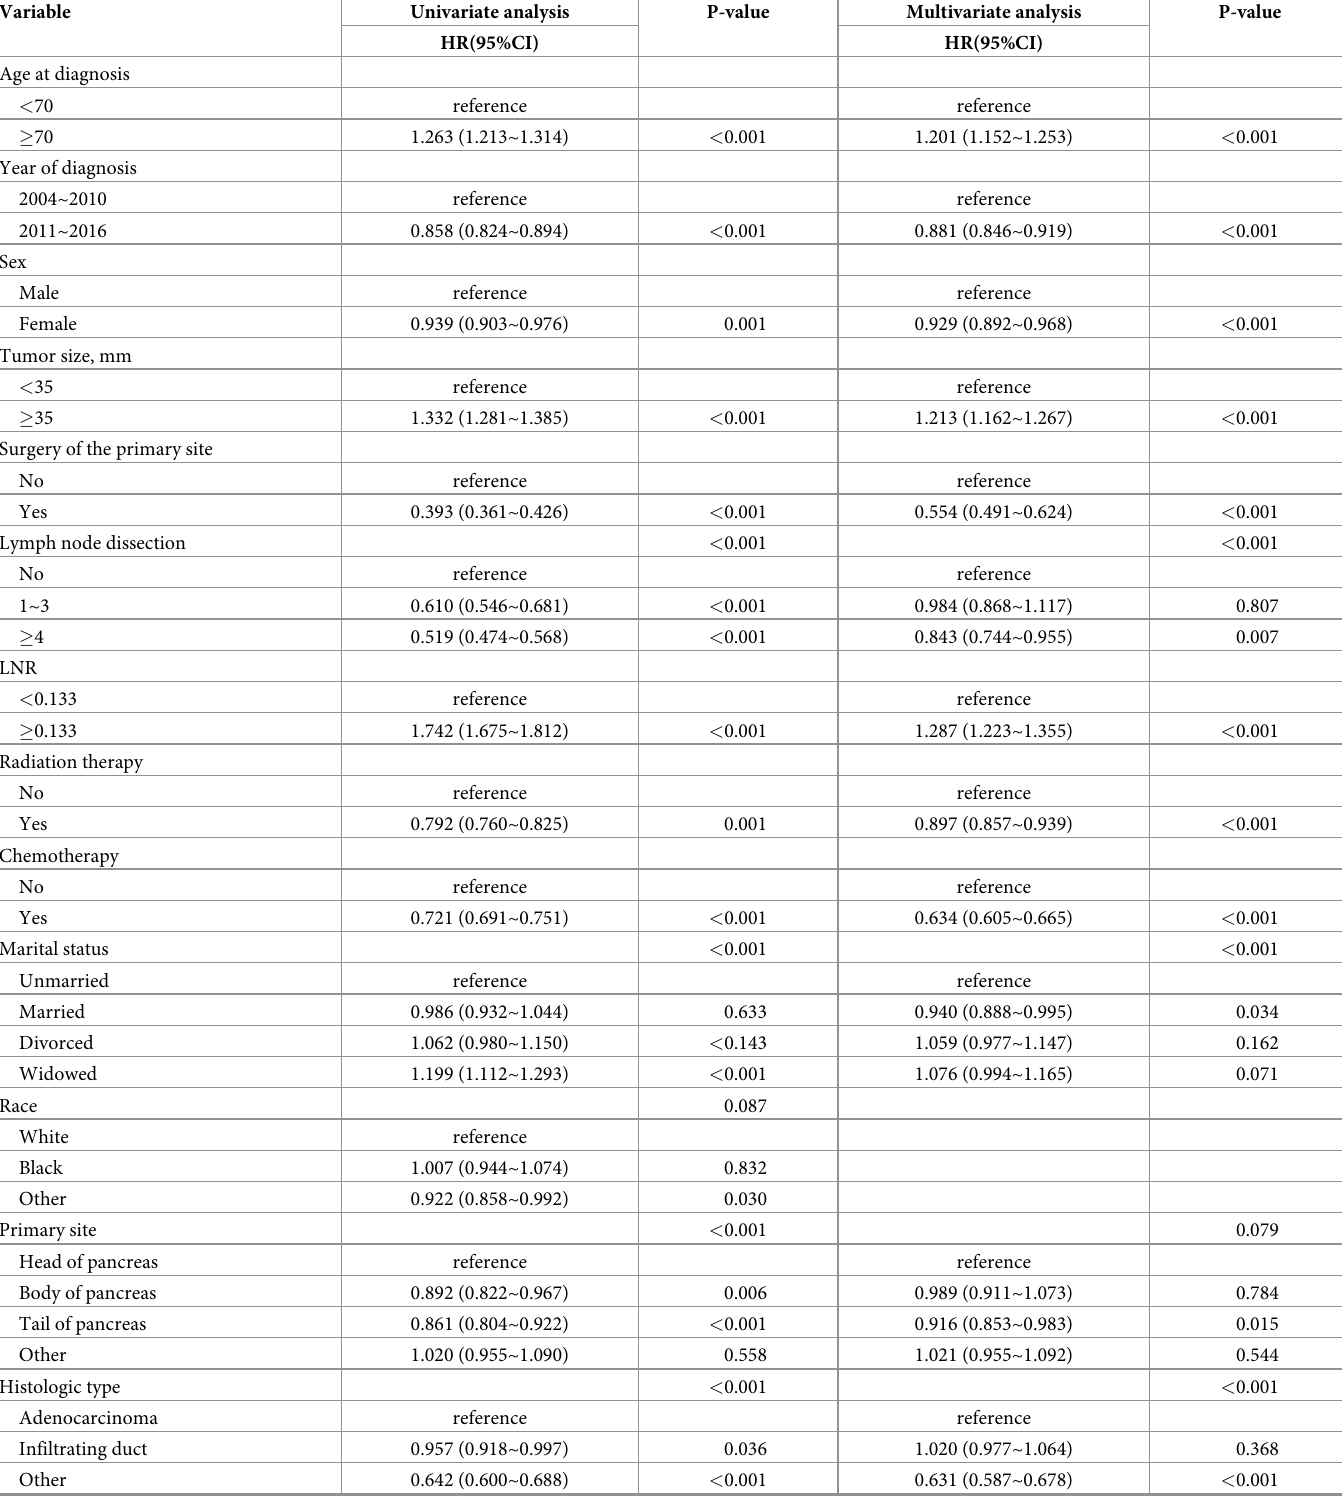
Table 2. Univariate and multivariate Cox regression analysis for OS in pancreatic cancer